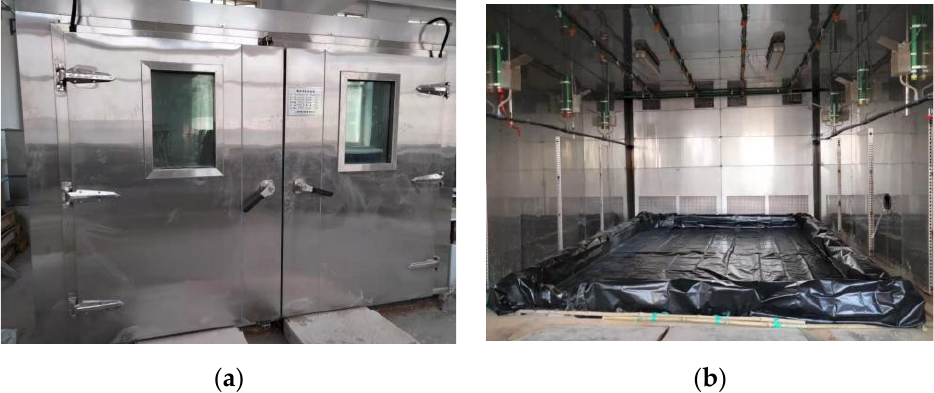
Figure 2. The environmental simulation test chamber. ( a ) Overall appearance; ( b ) Internal struc ‐ ture.